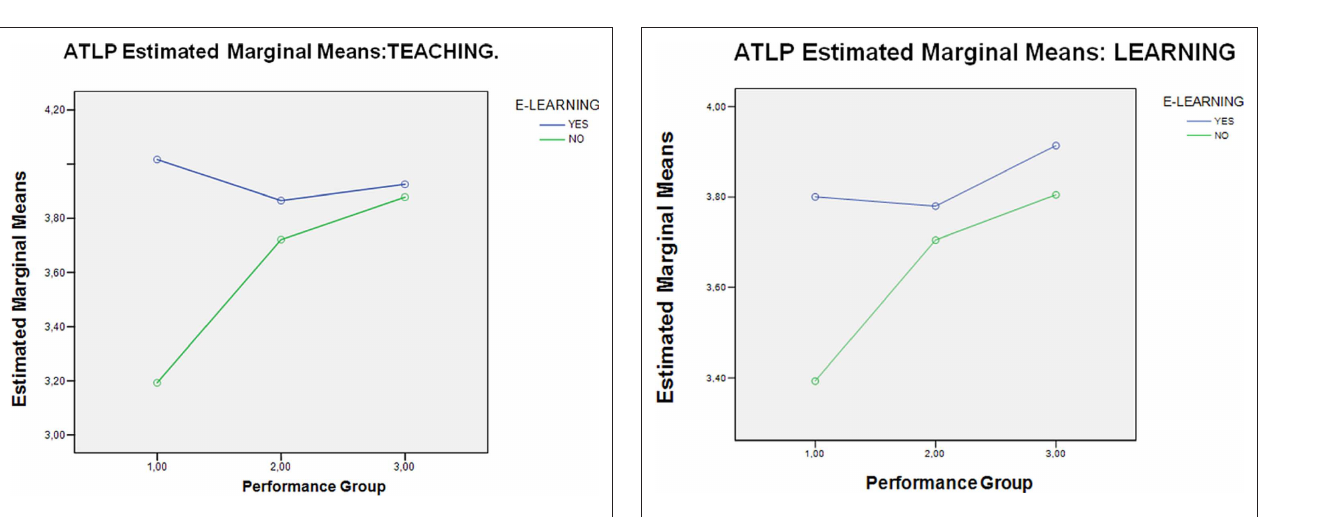
FIguRE 3 | Perception of the learning process, according to performance level, in class subjects with and without